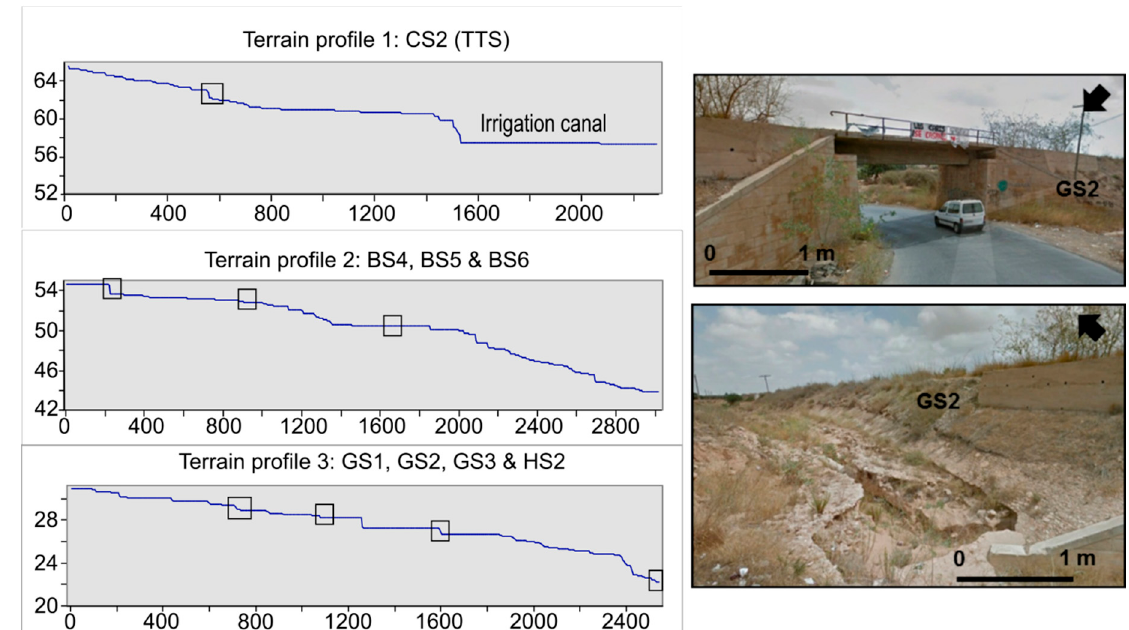
Figure 14. The left section shows the terrain profile for a longitudinal ephemeral stream channel. Human interventions have changed the erosive features (CS2, BS4, BS5, BS6, GS1, GS2, GS3, and HS2). The right section shows some groove evidence taken from Google Street Map (08/2012). The road and gabion wall both influence erosion.